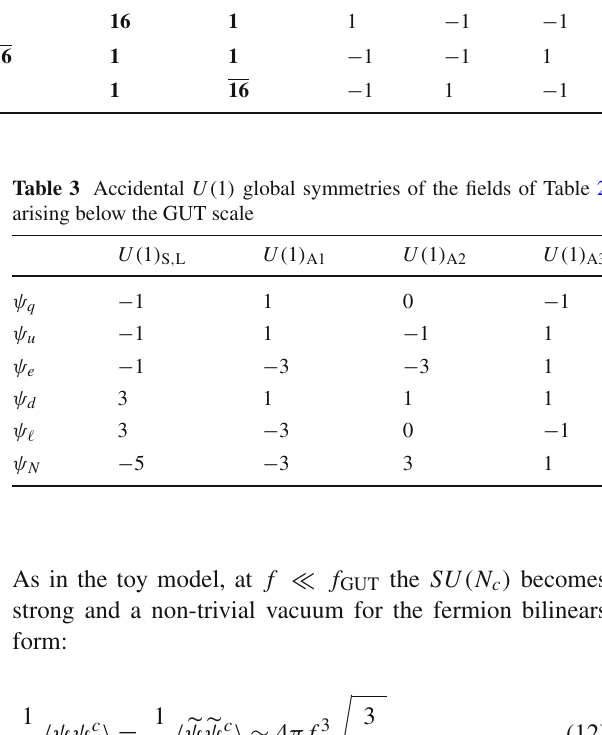
Table 2 Axion constituents and the abelian (continuous) accidental symmetries of the theory